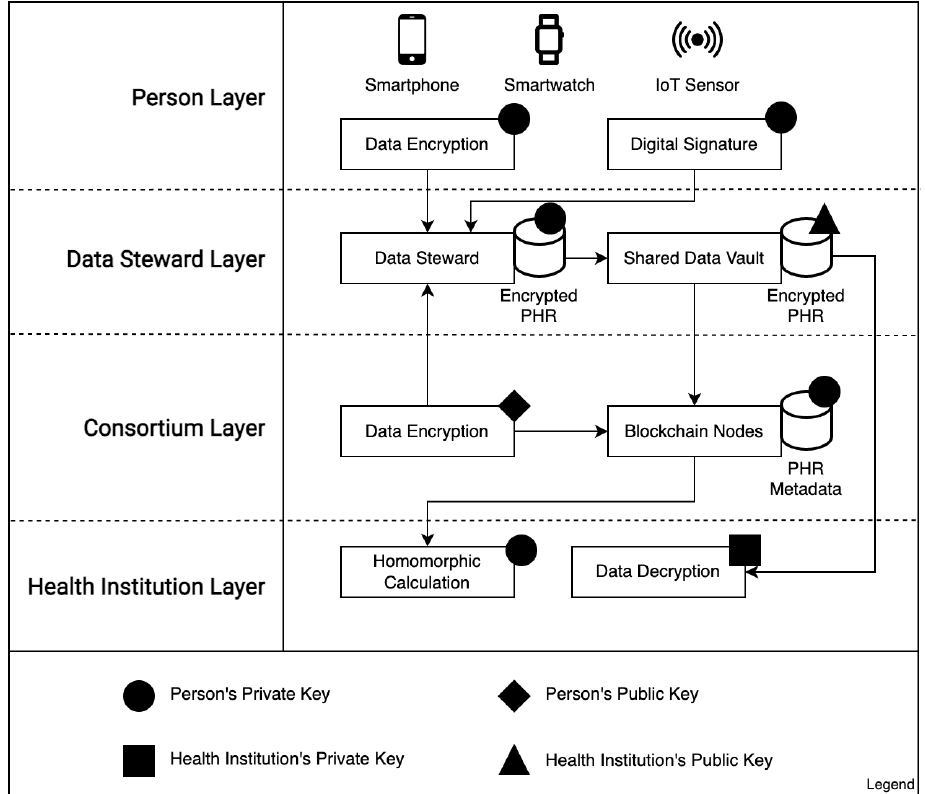
Figure 5. Key management and end-to-end encryption: Throughout their lifecycle, PHRs rely on different layers and demand proper encryption/decryption processes to fulfill requests from health institutions and private